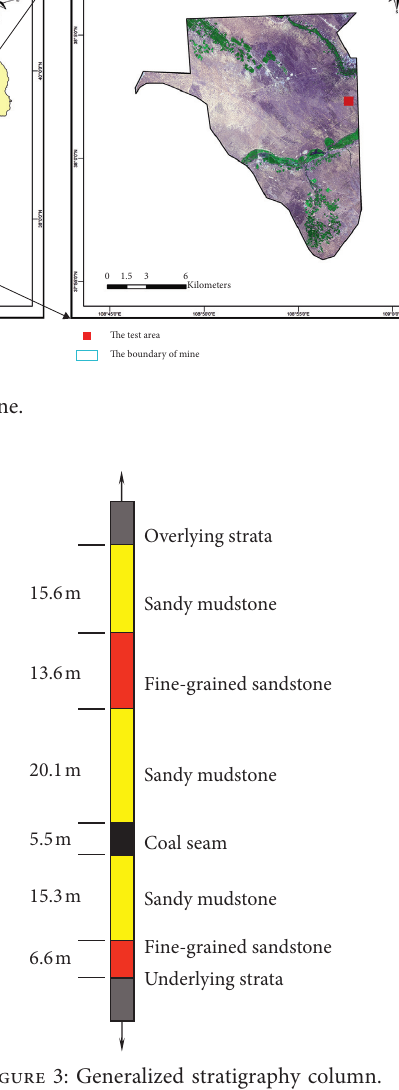
Figure 3: Generalized stratigraphy